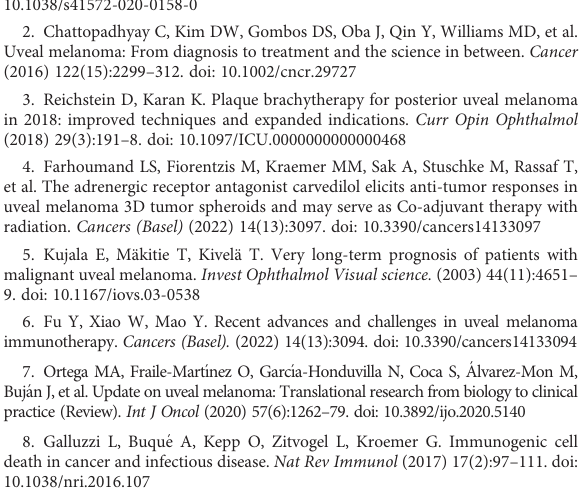
SUPPLEMENTARY TABLE 1 Genes and corresponding coef fi cients in ICD-related risk signature. SUPPLEMENTARY FIGURE 1 The experimental fl ow chart. SUPPLEMENTARY FIGURE 2 The progression-free survival (PFS) analysis between the high and low- risk groups. SUPPLEMENTARY FIGURE 3 Differential expression of genes. These immune checkpoint genes with a fraction less than 10 were shown in (A) . These immune checkpoint genes with a fraction less than 100 and more than 10 were shown in (B) . These immune checkpoint genes with a fraction more than 100 were shown in (C) . SUPPLEMENTARY FIGURE 4 The drug sensitivity comparison through the GDSC database between ICD-high and ICD-low risk groups. SUPPLEMENTARY FIGURE 5 The correlation between the expression level of ENTPD1, CASP8, LY96, FOXP3, and IL6 and drug sensitivity in pan-cancer through the CellMiner database. SUPPLEMENTARY FIGURE 6 The correlation between the expression level of ENTPD1, CASP8, LY96, FOXP3, and IL6 and drug sensitivity in pan-cancer through the GSCA